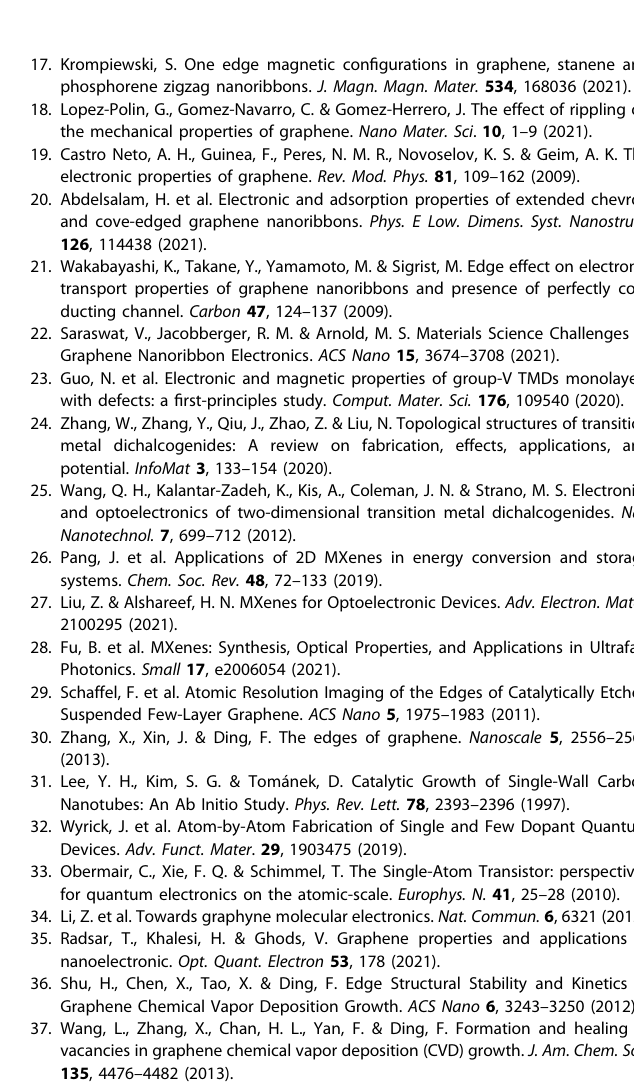
Fig. 14 Schematic summarizing the development of SAC for crystal growth. Four key aspects are identi fi ed, namely, SAC Physico-chemical properties, SAC crystal product, SAC grown crystal growth parameters and the resultant possibilities for